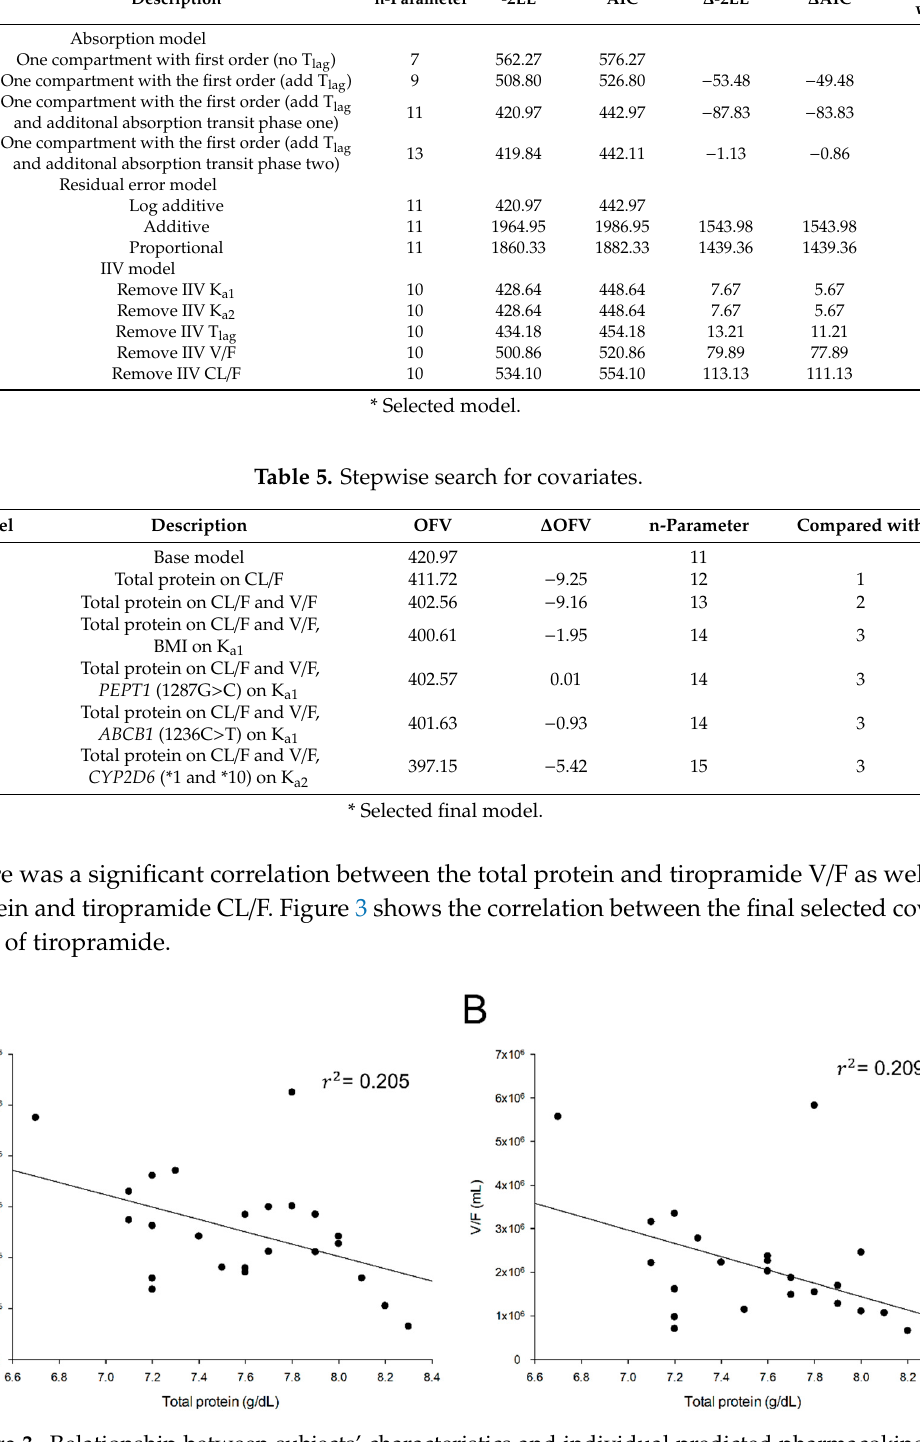
Figure 3. Relationship between subjects’ characteristics and individual predicted pharmacokinetic parameters. Clearance (CL/F) of tiropramide according to total protein ( A ). Volume of distribution (V/F) of tiropramide according to total protein ( B ).